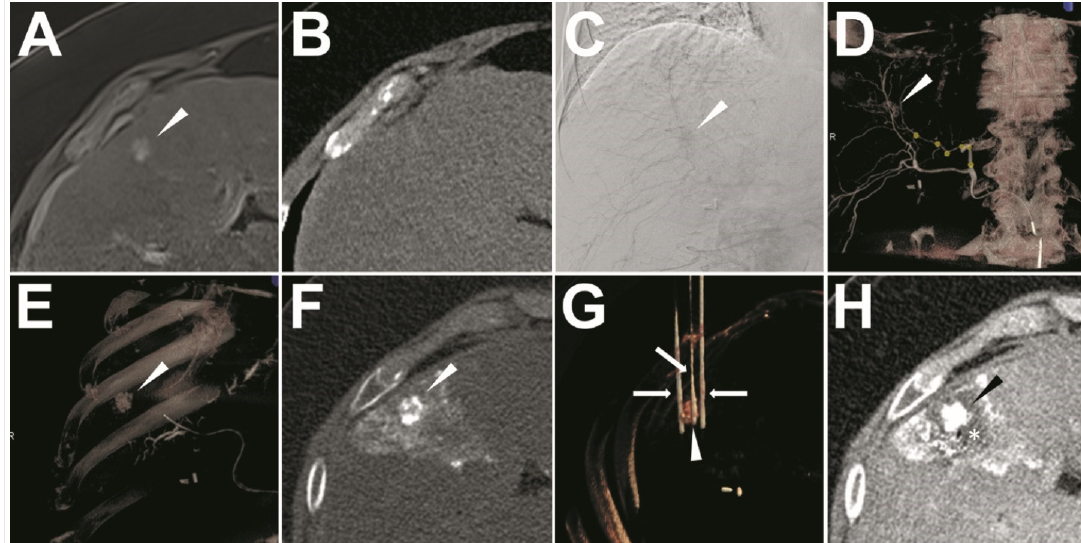
Figure 1. The exemplary illustration of the ethiodized oil tumor marking with sequential IRE treatment. A target-HCC (arrowhead) close to the diaphragm with typical arterial APHE was confirmed in enhanced MRI ( A ), which was invisible in pre-marking unenhanced CT ( B ). In the ethiodized oil tumor marking procedure, the opacity of the target-HCC was found in the celiac artery angiography ( C ). Then, the angiographic cone-beam CT was performed to navigate the micro- catheterization into the definite feeding artery (yellow round marks) of the target-HCC (arrowhead) in the 3D rendering image ( D ). After successful subsegmental micro-catheterization and ethiodized oil injection, the cone-beam CT was reperformed demonstrating visualization of target-HCC (arrowhead) ( E ). In post-marking CT, the target-HCC (arrowhead) could be defined visually with complete ethiodized oil accumulation (complete visualization) ( F ). In the subsequent IRE procedure, three (3) electrodes (arrow) were inserted surrounding the target-HCC (arrowhead) with a triangle configuration ( G ). Immediately after IRE, the enhanced CT scan was performed to identify the de-vascularized IRE zone (*) in the portal vein phase ( H